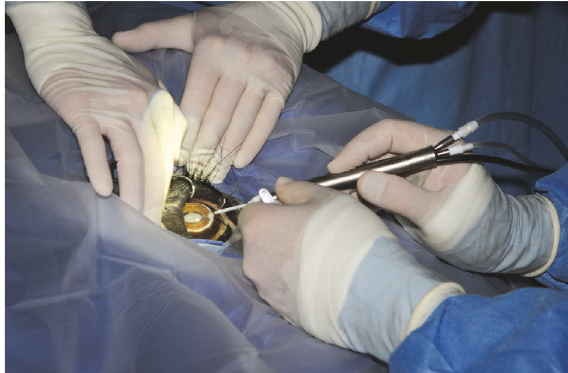
Figure 9: Phacoemulsification was performed using a 45-degree, 4 cm long handpiece designed specifically for horses (Acrivet, Veteri- nary Division of S&V Technologies AG, Hennigsdorf,